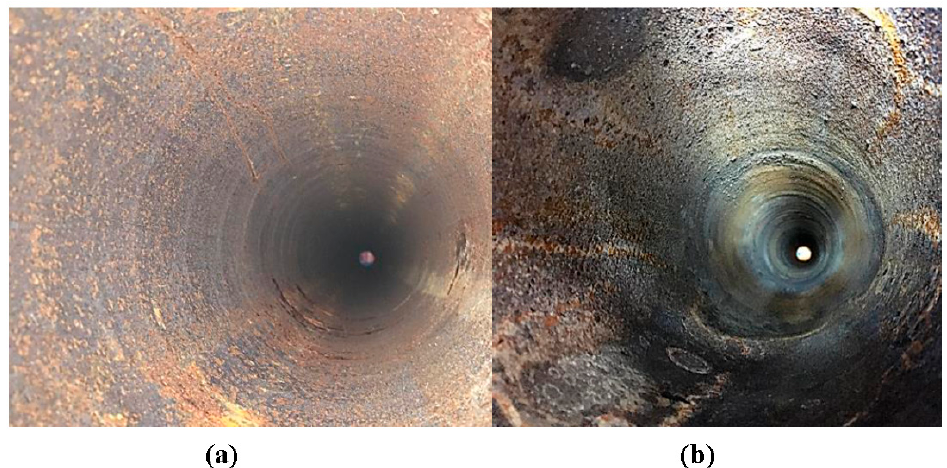
Figure 4. Image of the inner wall of the 6.2-m 6-inch schedule 40 carbon steel pipe ( a ) displaying some